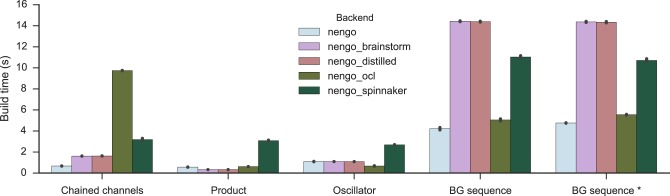
Build time for each model on each backend. Each bar represents the mean build time across 50 instances of each model; error bars are bootstrapped 95% confidence intervals. BG Sequence * refers to the basal ganglia sequence model in which passthrough nodes have been removed.